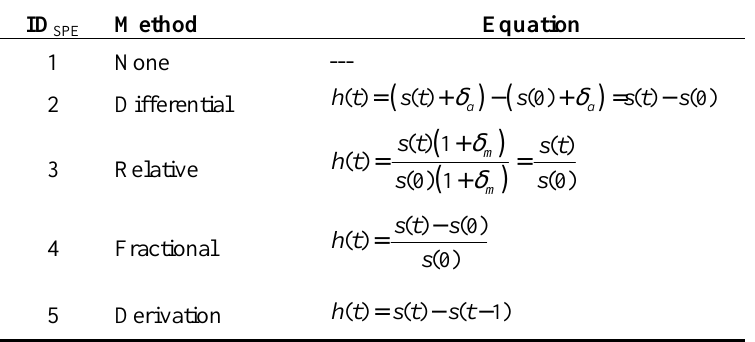
Table 2. List of signal pre-processing and enhancement methods used for gas sensor systems filled in the design tool of ADIMSS.